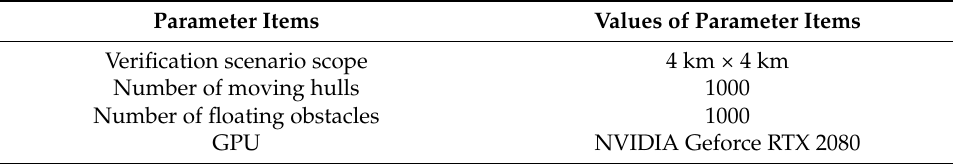
Table 1. Scene used for the verification of